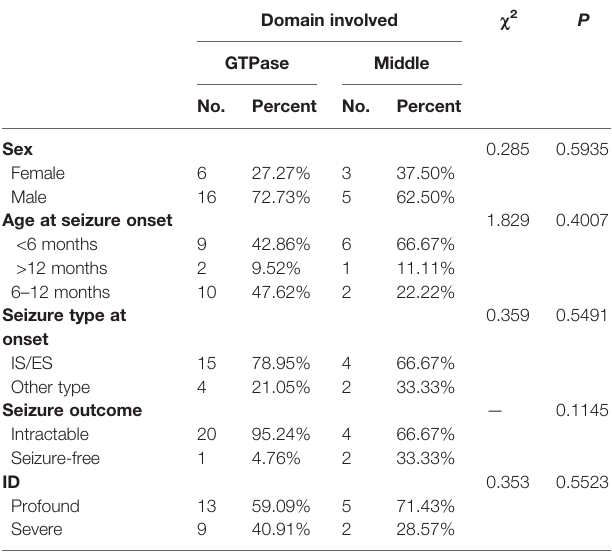
TABLE 3 | Comparison of gene domains and clinical features of 31 cases with mutation-related epileptic encephalopathy. Domain involved c